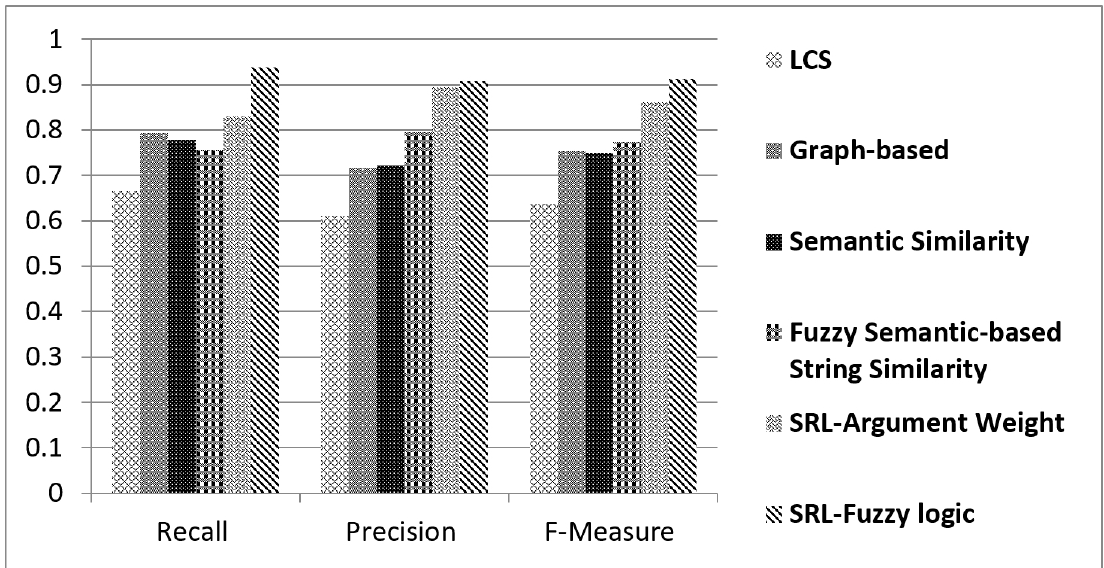
Figure 9. Contrast between the current text-based similarity detection methods.